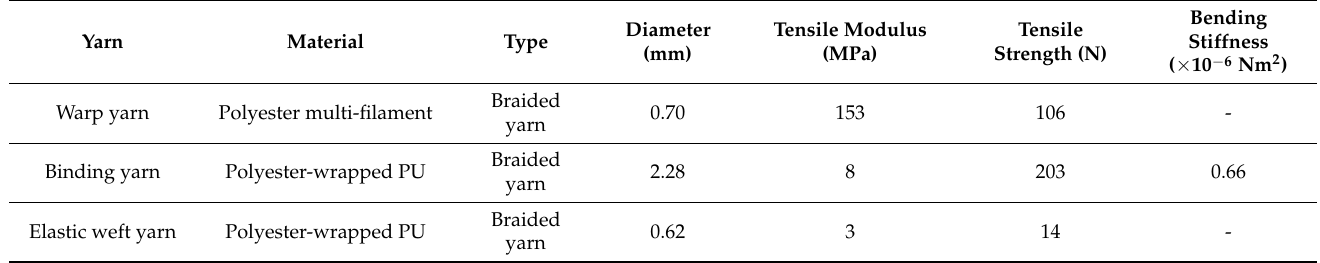
Table 1. Properties of the yarns used for sample preparation.